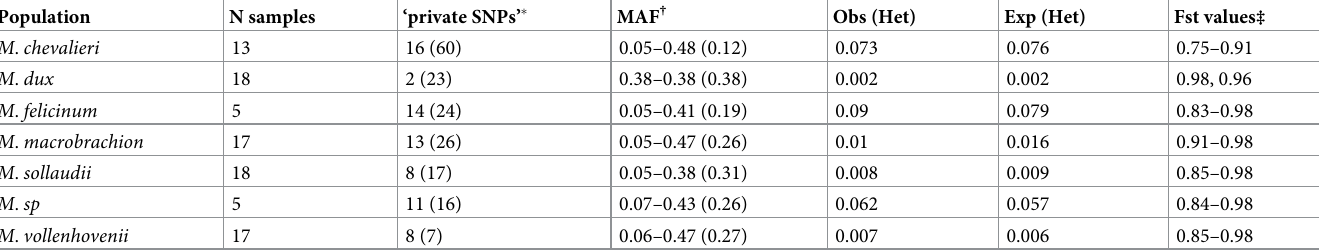
Table 1. Summary statistics of the ’private SNPs’ (‘private SNPs80’; N = 72) identified in the study. Population